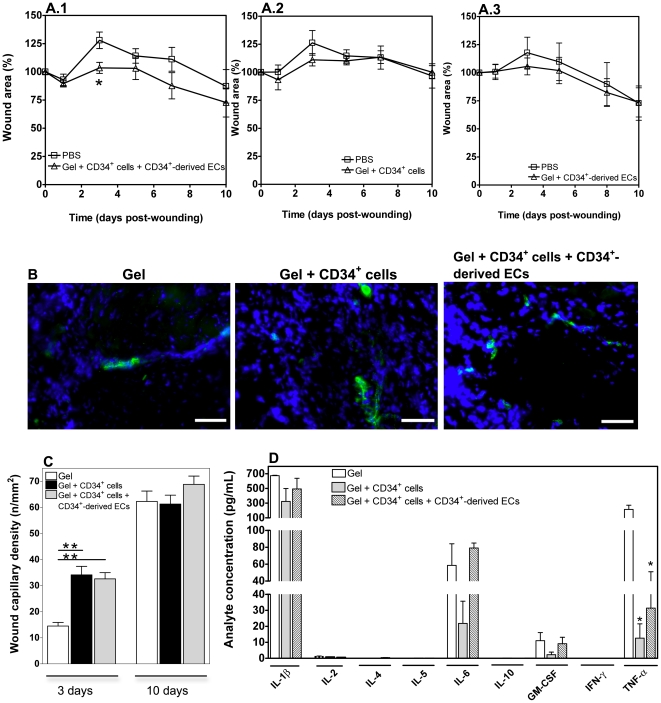
Regenerative effect of encapsulated CD34+ cells and CD34+-derived ECs on diabetic wounds.A) Wound closure (relatively to initial wound area) in diabetic mice treated by topical application of 1×105 CD34+ cells and 0.35×105 CD34+-derived ECs (A.1), CD34+ cells (A.2) or CD34+-derived ECs (A.3), encapsulated in fibrin gels. Control wounds received a saline solution (PBS) only. Results are average ± SEM, n = 6. * denotes statistical significance (P<0.05). B) Representative images of vWF immunostaining of wounds at day 3. Scale bar represents 50 µm. C) Quantification of wound capillary density (number of capillaries per mm2), based on the vWF immunostaining results, for 3 and 10 day-old wounds in the different experimental groups. Results are average ± SEM, n = 3. ** denotes statistical significance (P<0.001). D) Cytokine expression on mouse wound samples excised 3 days post-wounding, as determined by a Bio-Plex mouse cytokine assay. Wounds had been treated by topical application of CD34+ cells or CD34+ cells plus CD34+-derived ECs encapsulated in fibrin gels. Control wounds received fibrin gel alone. Results are average ± SD, n = 3.